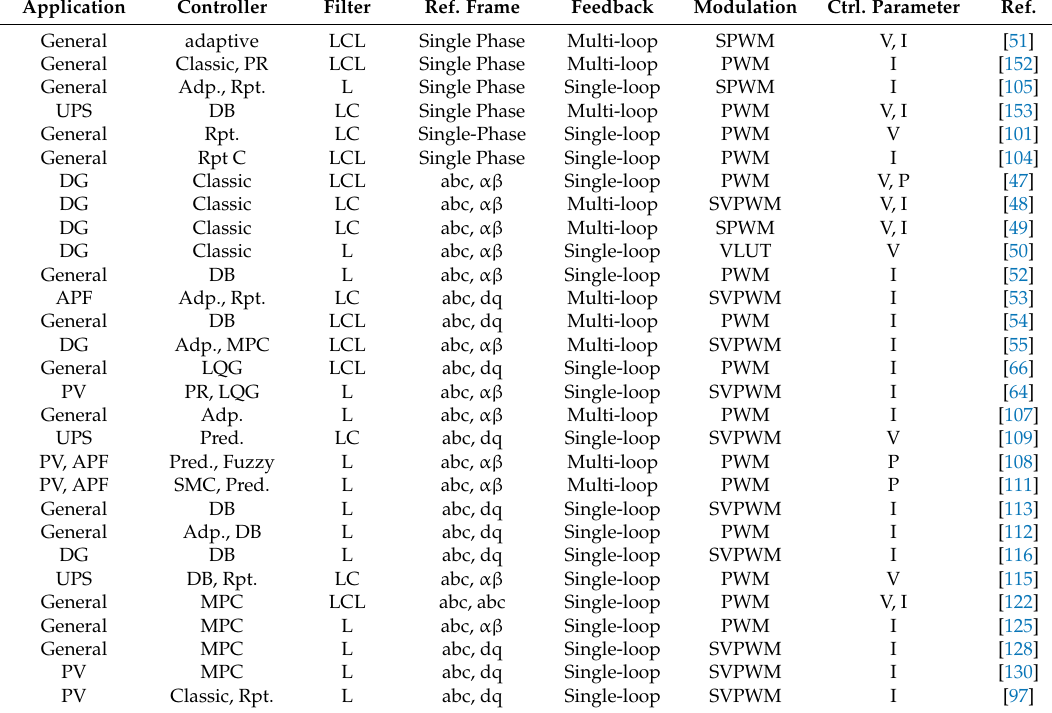
Table 3. Digital control system characteristics in numerous credible scientific